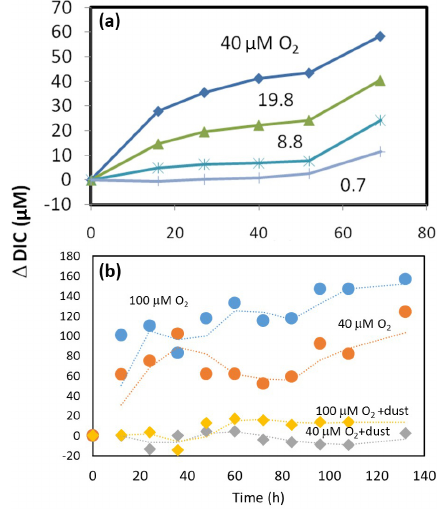
Figure 7. Incubation studies evaluating the change in DIC under different initial oxygen conditions (a) and with or without added dust from the Sahara (b) . Sinking particles from station 3, 80m depth, were added to incubation bags and alkalinity, pH and nutri- ents were measured. DIC calculated assuming that the only changes to the alkalinity were driven by changes in nutrient concentrations (Van Mooy et al., 2002). Dashed lines denote a running average of 2